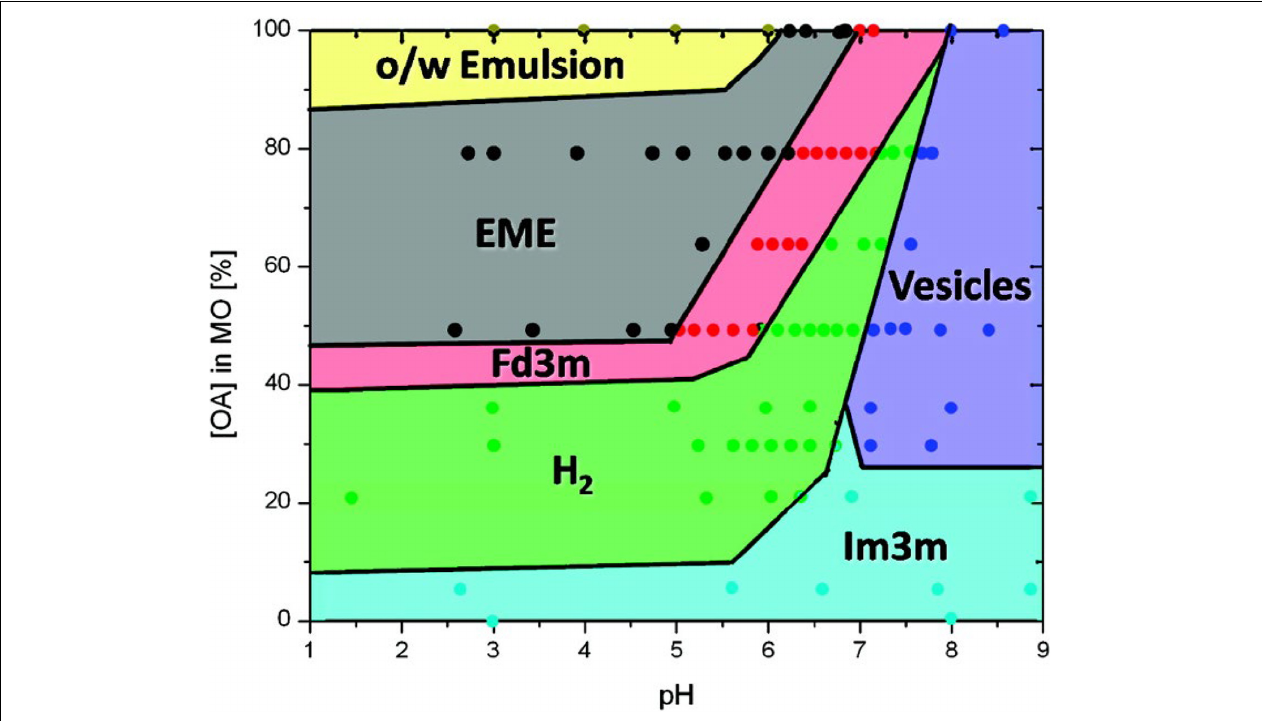
FIGURE 8 | A phase behavior diagram of monoolein and oleic acid mixtures in PBS buffer with pH of 1–9 at 25 ◦ C, constructed by Salentinig et al. (2010a). Phases were determined via SAXS analysis of pre-made dispersions of the lipids. Adapted with permission from Salentinig et al. (2010a). Copyright (2010) American Chemical